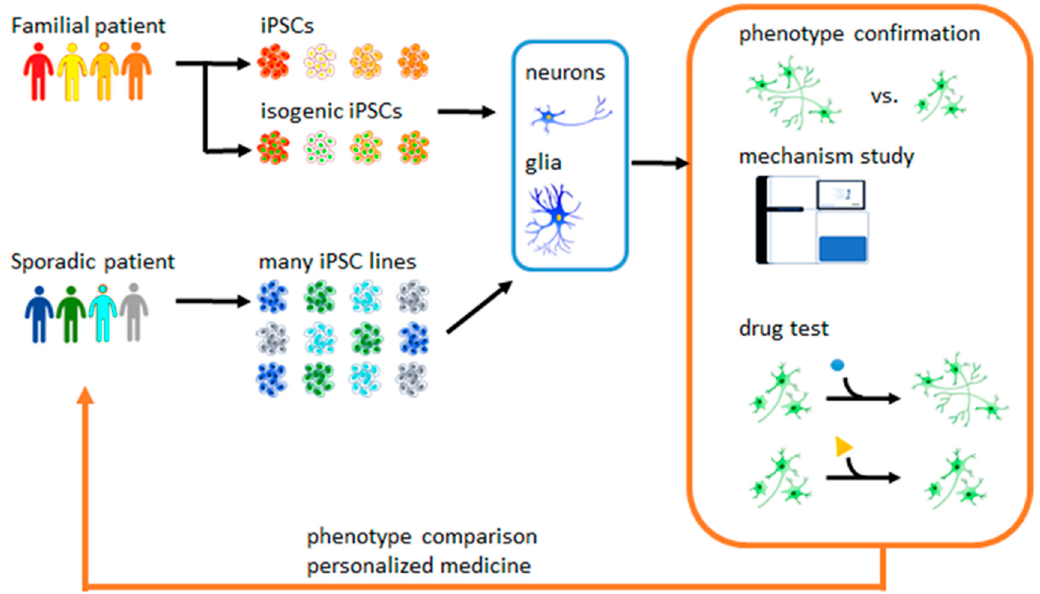
Figure 1. Apply induced pluripotent stem cells (iPSC)-derived neurons/glia for neurological disease phenotype confirmation, mechanism study, and drug test. Table 1. List of publications that applied pluripotent stem cells for neurodegenerative disease modeling.